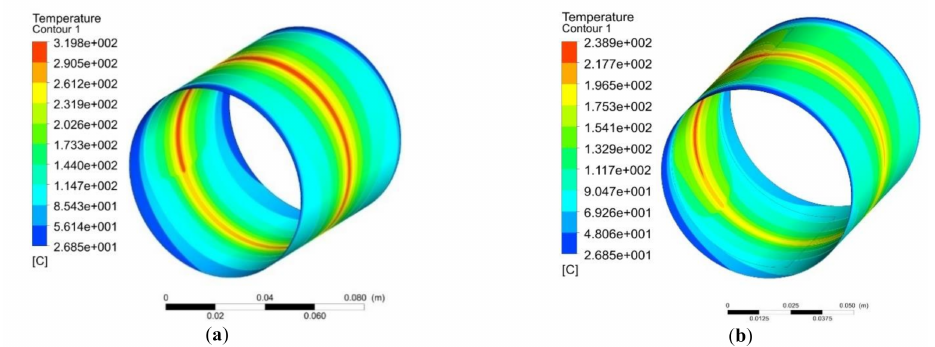
Figure 10. Comparison of the contour of temperature between ( a ) the conventional (no-slip) bearing and ( b ) the heterogeneous slip/no-slip bearing. All results are evaluated at n = 3000 rpm.